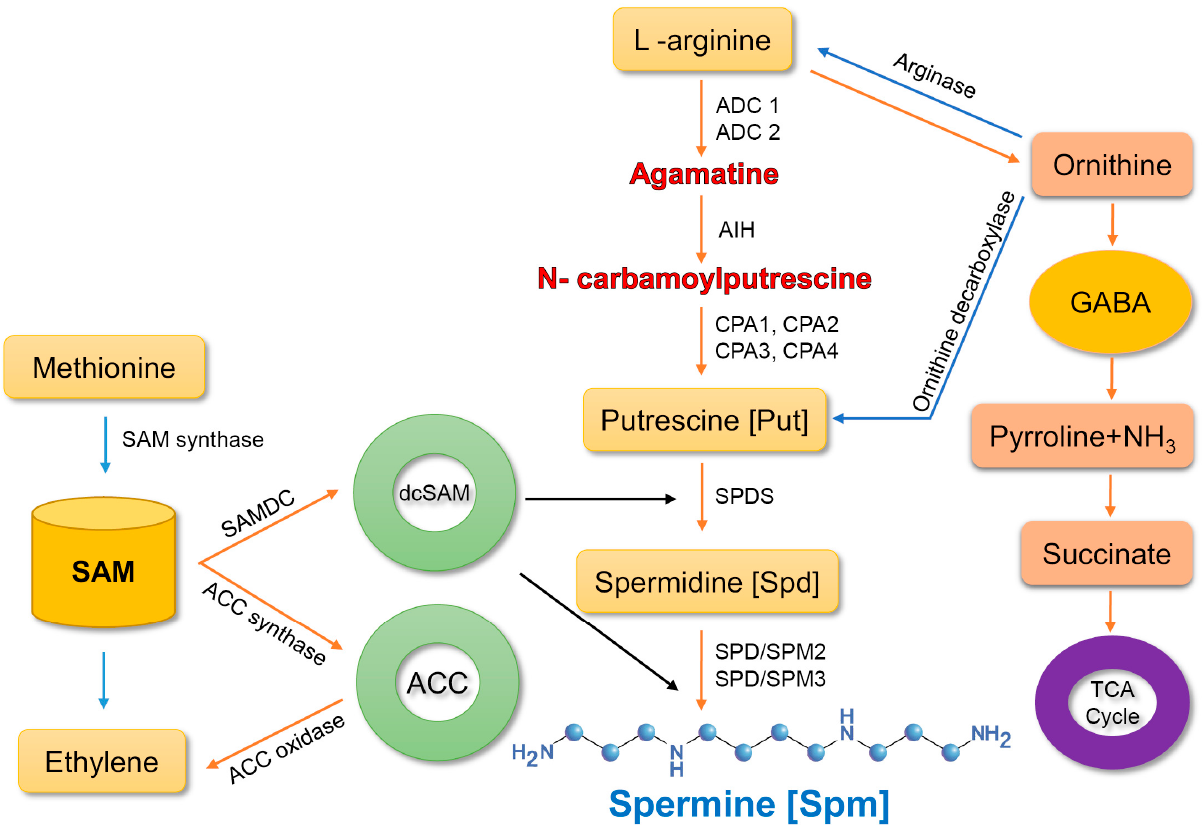
Figure 1. Spermine biosynthesis in plants. ADC, arginine decarboxylase; AIH, agmatine iminohydrolase; CPA-N, carbamoylputrescine amidohydrolase; SPDS, spermidine synthase; SPMS, spermine synthase; GABA, γ -aminobutyric acid; SAM-S, adenosylmethionine; SAMDC-S, adenosylmethionine decarboxylase; dcSAM, decarboxylated S-adenosylmethionine; ACC, 1-aminocyclopropane-1-carboxylic-acid synthase. Arrows represent synthesis and conversion.